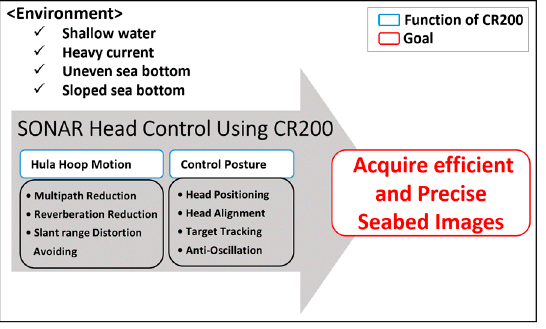
Figure 8. Two main functions of the CRABSTER (CR200) for the acquisition of efficient and precise seabed images.